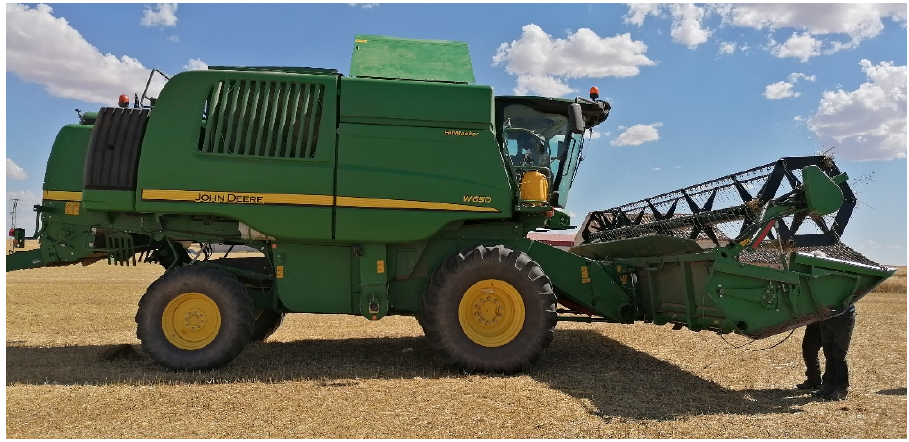
Figure 2. John Deere W650 combine harvester equipped with a cereal header. Table 1. Combine harvester (John Deere W650) settings used during harvesting of camelina. Parameter Setting Rotor speed (rpm)